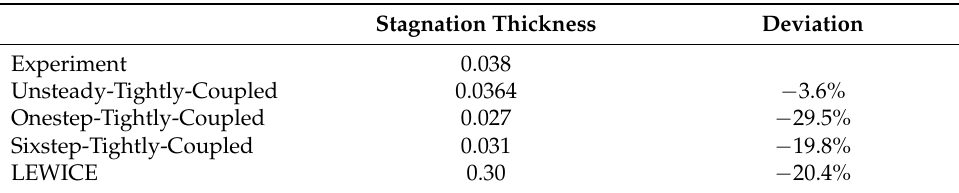
Table 4. Deviations of stagnation thickness.